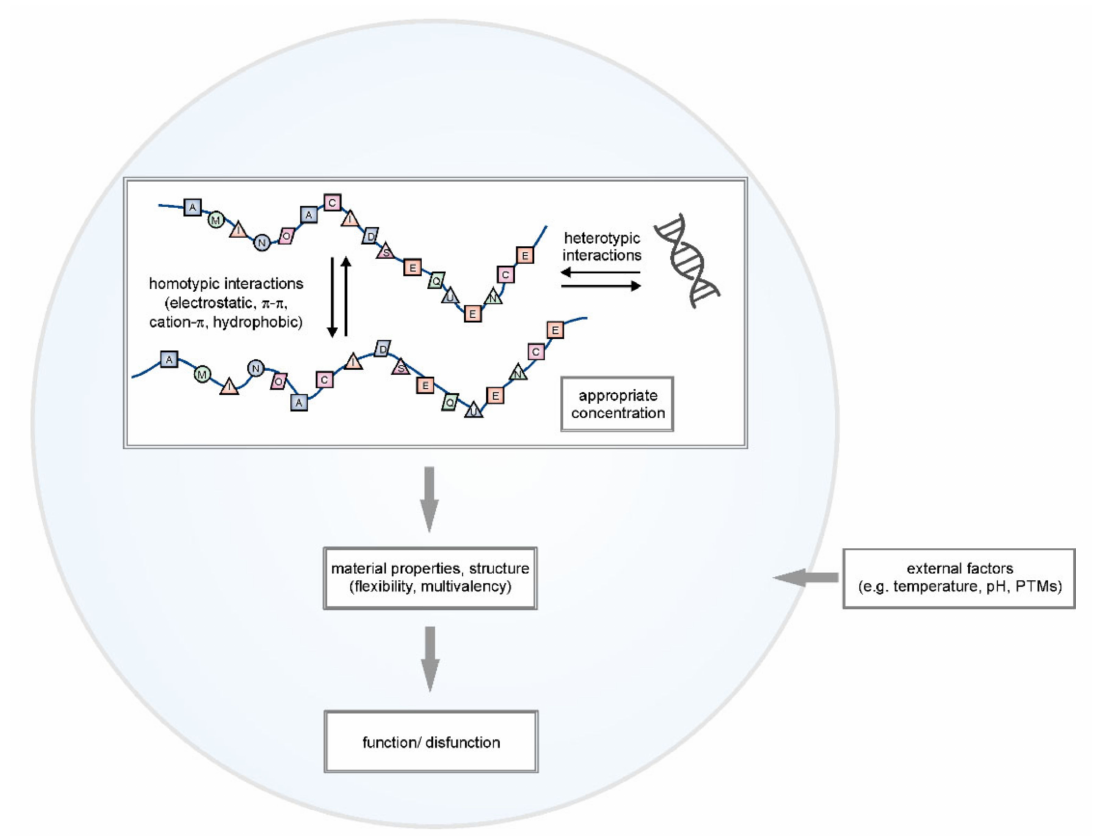
Figure 1. LLPS from amino acid sequence to function. The amino acid composition and the overall sequence patterns determine the interactions, material properties, and structure of protein that encodes the ability to undergo liquid–liquid phase separation. Homo- and heterotypic interactions are depicted. The important regulatory factor is the environment. All these elements define the function or disfunction of particular MLOs (see text for